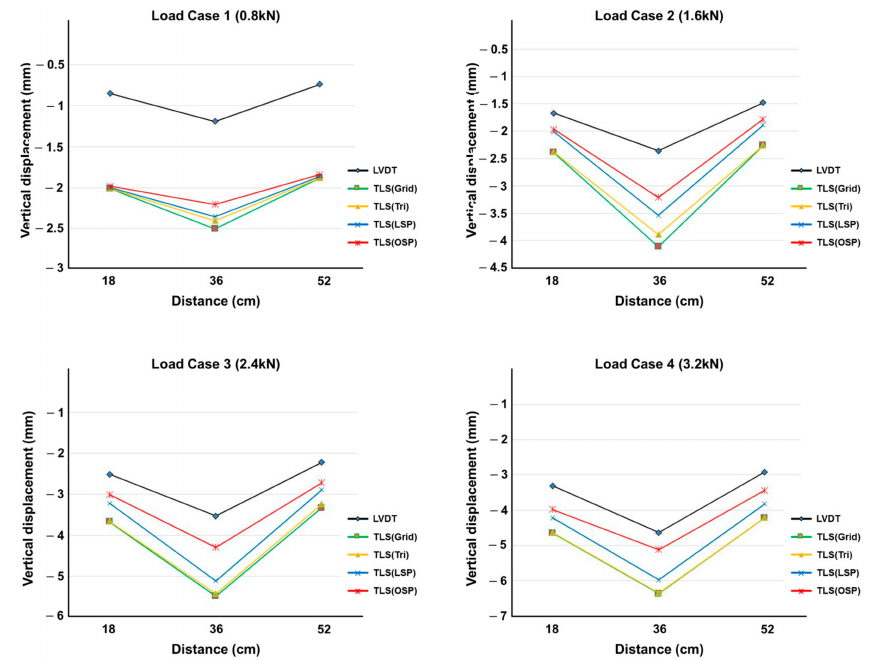
Figure 12. Comparison of vertical displacement between LVDT and the four methodologies (12 mm